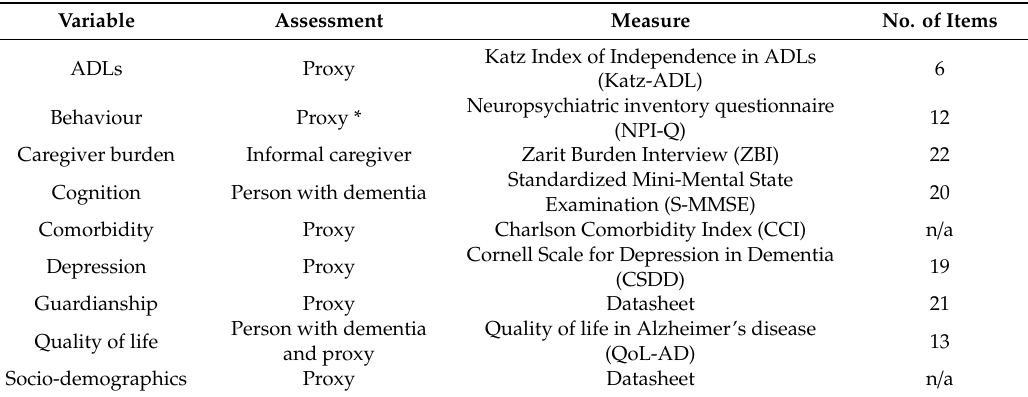
Table 1. Measurements included and related to the situation of the person with